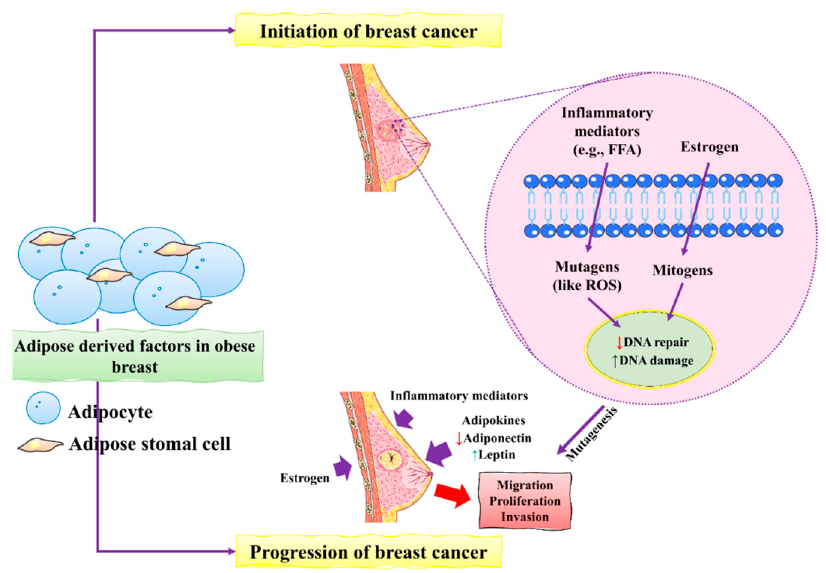
Figure 1. The initiation and progression of BC by obese breast adipose-derived factors. Factors released by obese breast adipose tissue may operate as mutagens, for example by activating intracellular reactive oxygen species (ROS), which can lead to DNA damage in normal breast epithelial cells and other inflammatory mediators. DNA damage may occur as a result of estrogen’s mitogenic actions, which can lead to replication stress and stress. Unresolved DNA damage, which is associated with mutagenesis and the onset of cancer, may result from increased DNA damage and possible estrogen-induced defective DNA repair. An obese breast adipose tissue microenvironment promotes BC proliferation, migration, and invasion by releasing inflammatory mediators, increasing leptin, decreasing adiponectin, and increasing estrogen levels. This figure is reproduced from Bhardwaj et al. [40] (Creative Commons Attribution License (CC BY 4.0)).